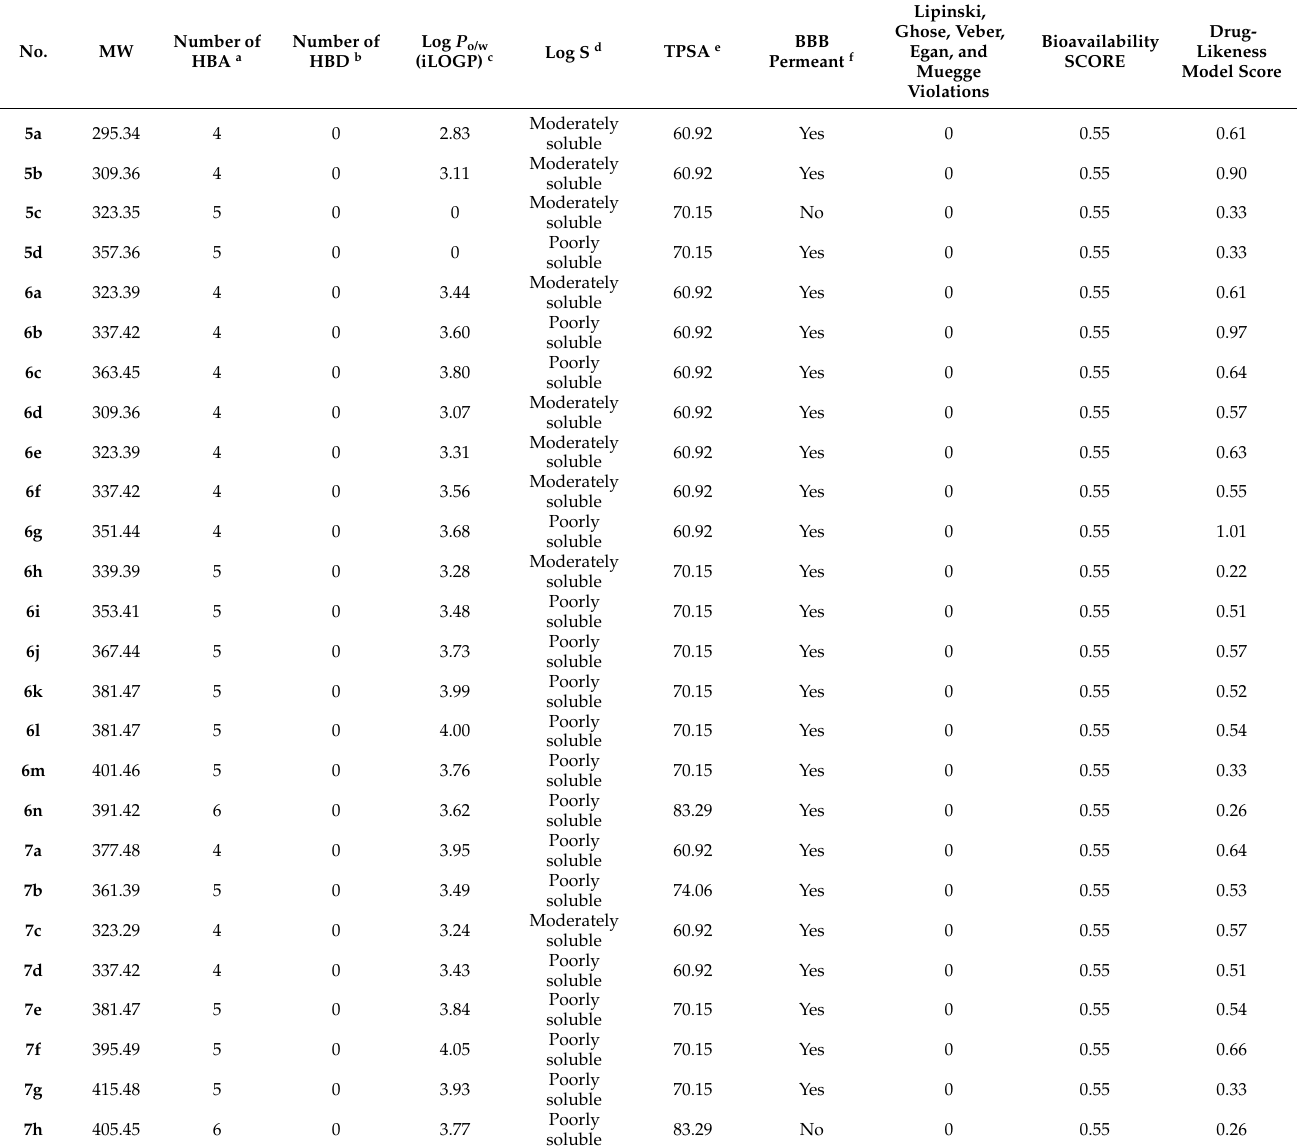
Table 10. Drug likeness predictions and Physicochemical-Pharmacokinetic/ADME properties of tested compounds.